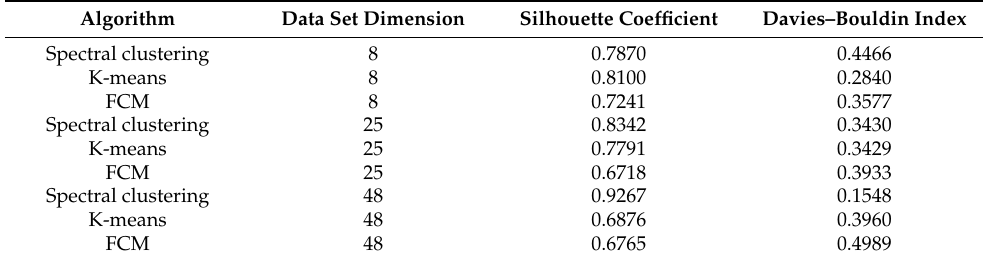
Figure 5. Contour coefficient map based on different clustering algorithms. ( a ) Plot of silhouette coefficients for different dimensional datasets. ( b ) Plot of Davies–Bouldin indexes for different dimensional datasets. Table 1. Comparative metrics of clustering effects of different algorithms.